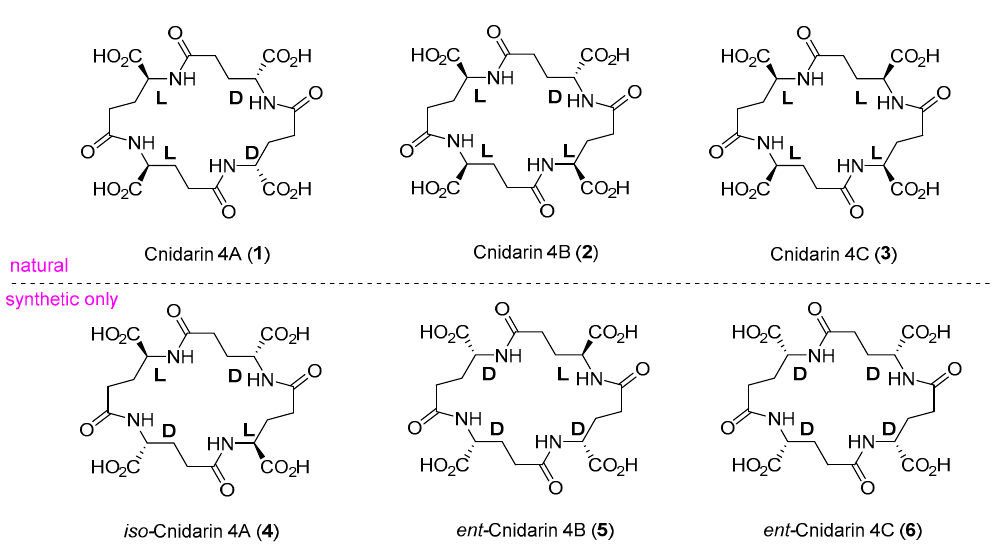
Figure 1. Structure of naturally occurring cyclic tetra- γ -glutamic acids 1 – 3 and synthetic analogues 4 – 6 .